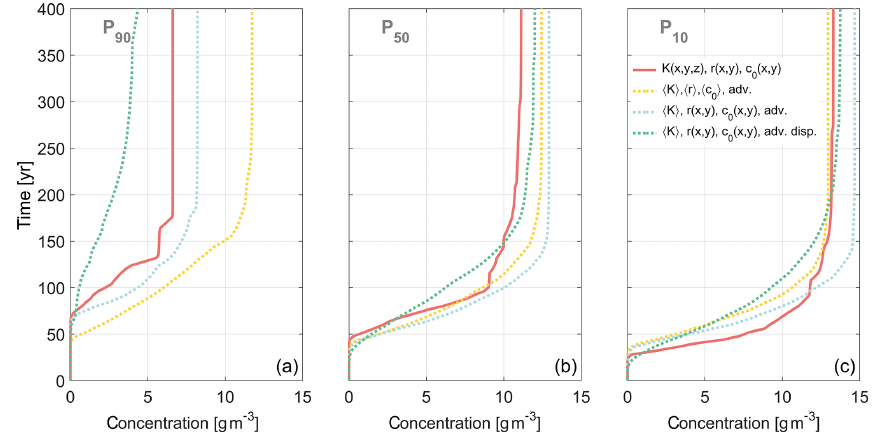
Figure 10. Time ( y axis) required for a well to exceed a given concentration ( x axis) with a probability of 90% (a) , 50% (b) and 10% (c) considering a heterogeneous K field, heterogeneous r and heterogeneous c 0 (reference case, red solid line); an upscaled K value, averaged r and averaged c 0 accounting for advection only (yellow dashed line); an upscaled K value, heterogeneous r and heterogeneous c 0 accounting for advection only (blue dashed line); an upscaled K value, heterogeneous r and heterogeneous c 0 accounting for advection and dispersion (green dashed